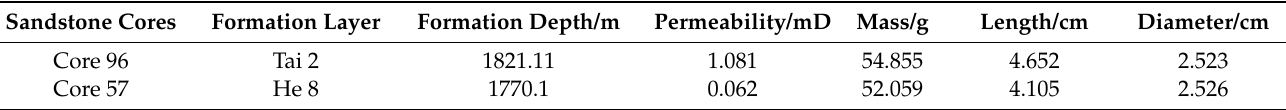
Figure 2. Experimental cores and the fracturing fluid. Table 1. Parameters of the sandstone cores in Linxing tight gas reservoir.